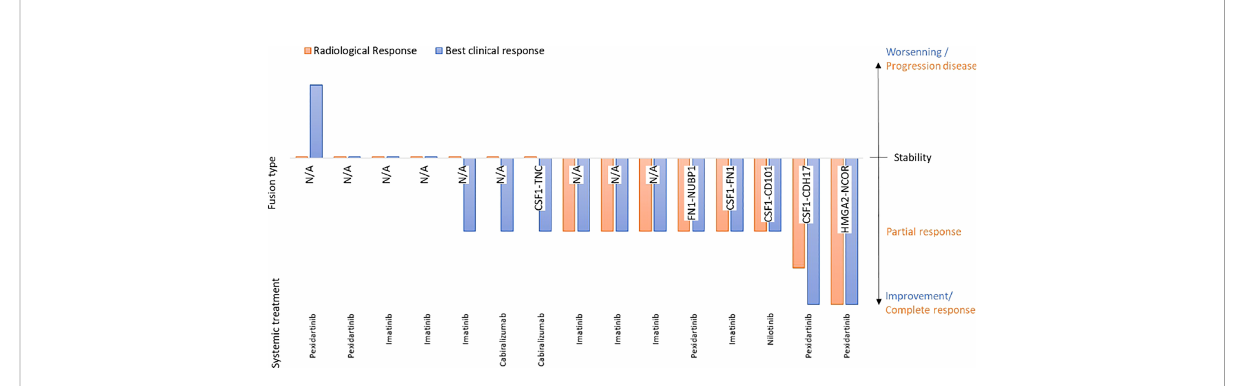
FIGURE 4 Correleation between gene fusion and medical treatment ef fi